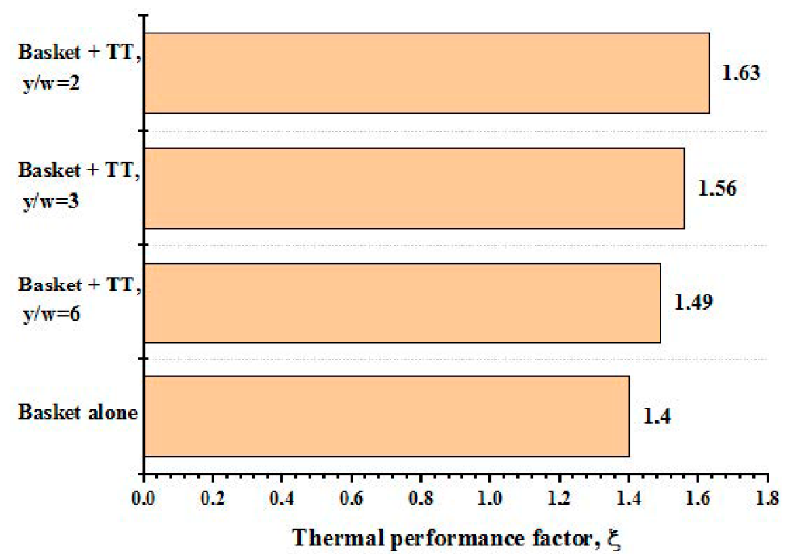
Figure 9. Percentage of thermal performance factor enhancement.